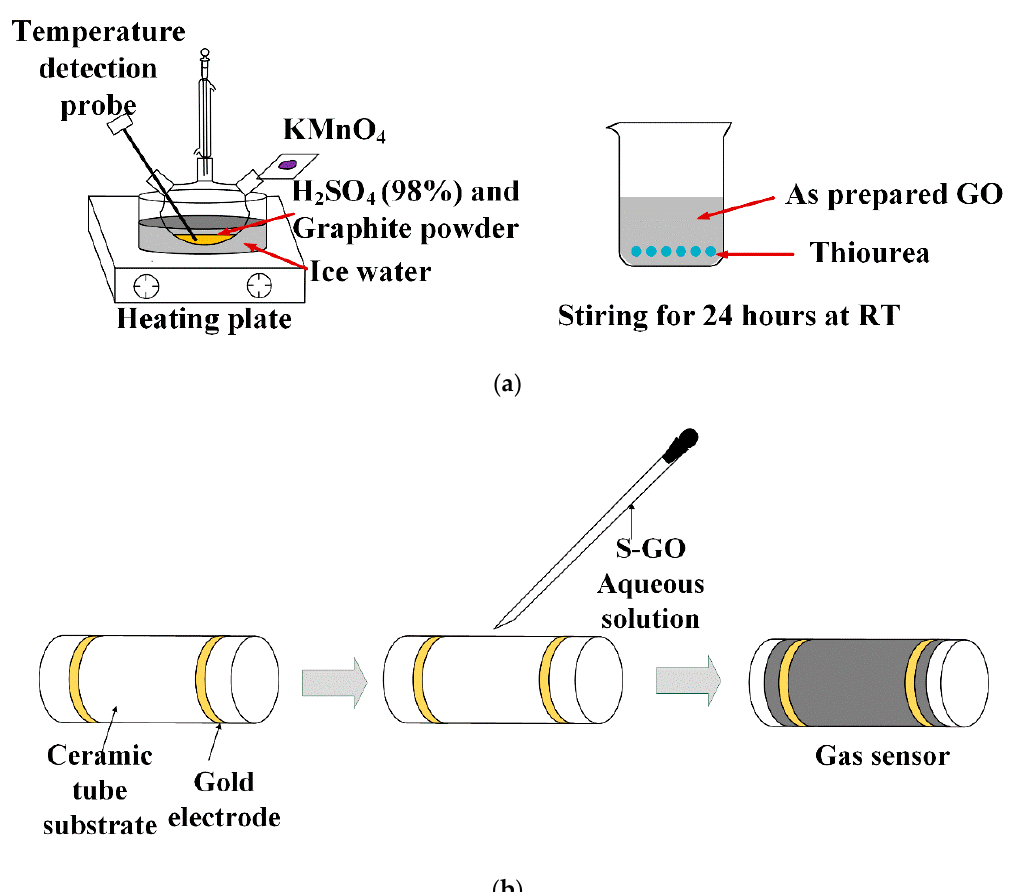
Figure 1. Schematic illustration of ( a ) the synthesis of graphene oxide and S-doped graphene and ( b ) fabricated gas sensor based on S-doped graphene.